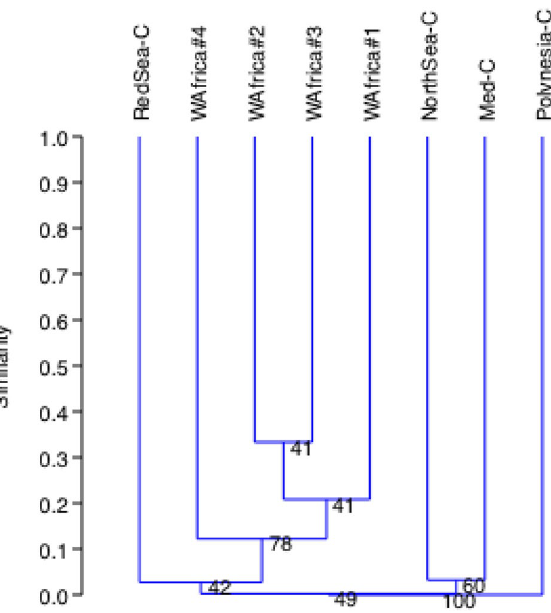
Figure 5. Clustering analysis of sample diversity. UPGMA based on Bray–Curtis distance matrices constructed from presence (1)/absence (0) of the species detected from DNA metabarcoding (10,000